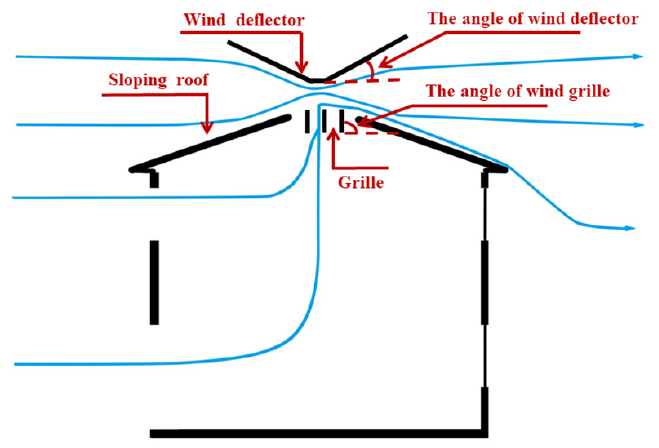
Figure 1. Schematic diagram of a venturi cap.